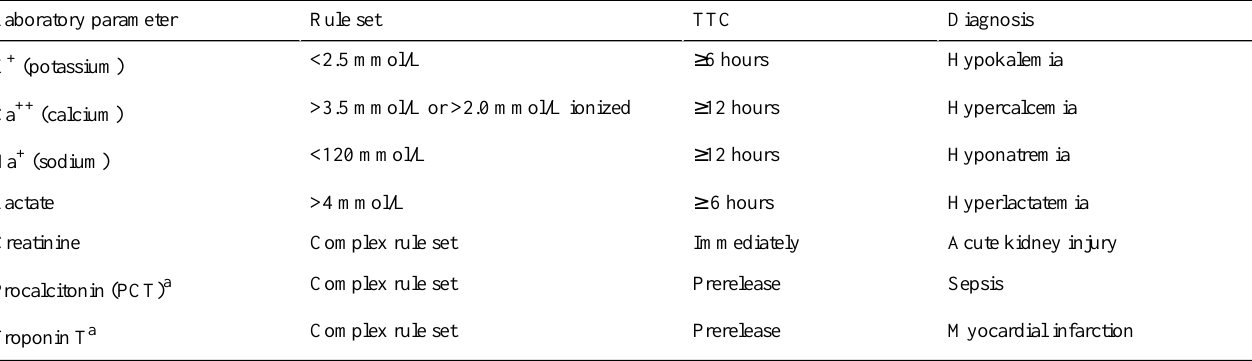
Table 1. Laboratory parameters, rule sets, time to control (TTC), and diagnosis from AMPEL. Each line comprises a specific algorithm. If any parameter value falls outside the defined range (rule set), the diagnosis is documented, and notifications are sent to warn clinicians in the inpatient units. DiagnosisTTCRule setLaboratory